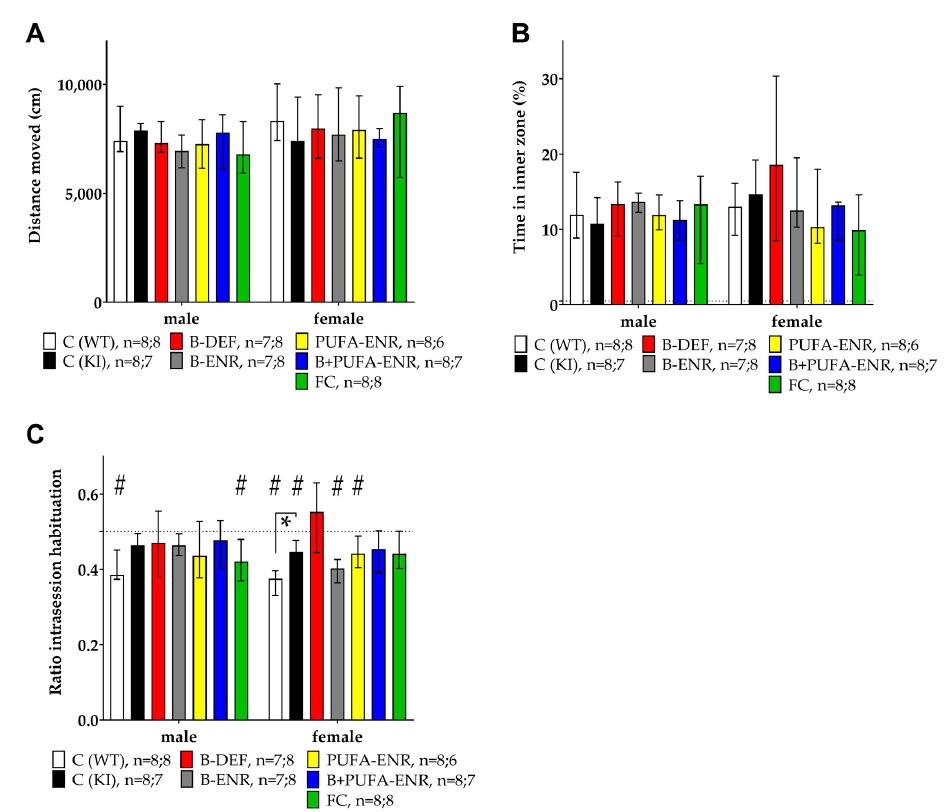
Figure 4. Open field test (30 min) in 15 weeks old C57BL / 6J and App NL-G-F mice; 10 weeks on experimental diet; data presented as median ± IQR; outliers beyond threefold IQR removed; p < 0.05 (Mann-Whitney-U-test) considered statistically significant (*). ( A ) Total distance moved. ( B ) Percentage of time spent in inner zone. ( C ) Intrasession habituation expressed as ratio between the distance moved in the final time block divided by the sum of the final and the initial time block. ( # ) Ratio di ff erent from 0.5 (one-sample Wilcoxon signed rank test).